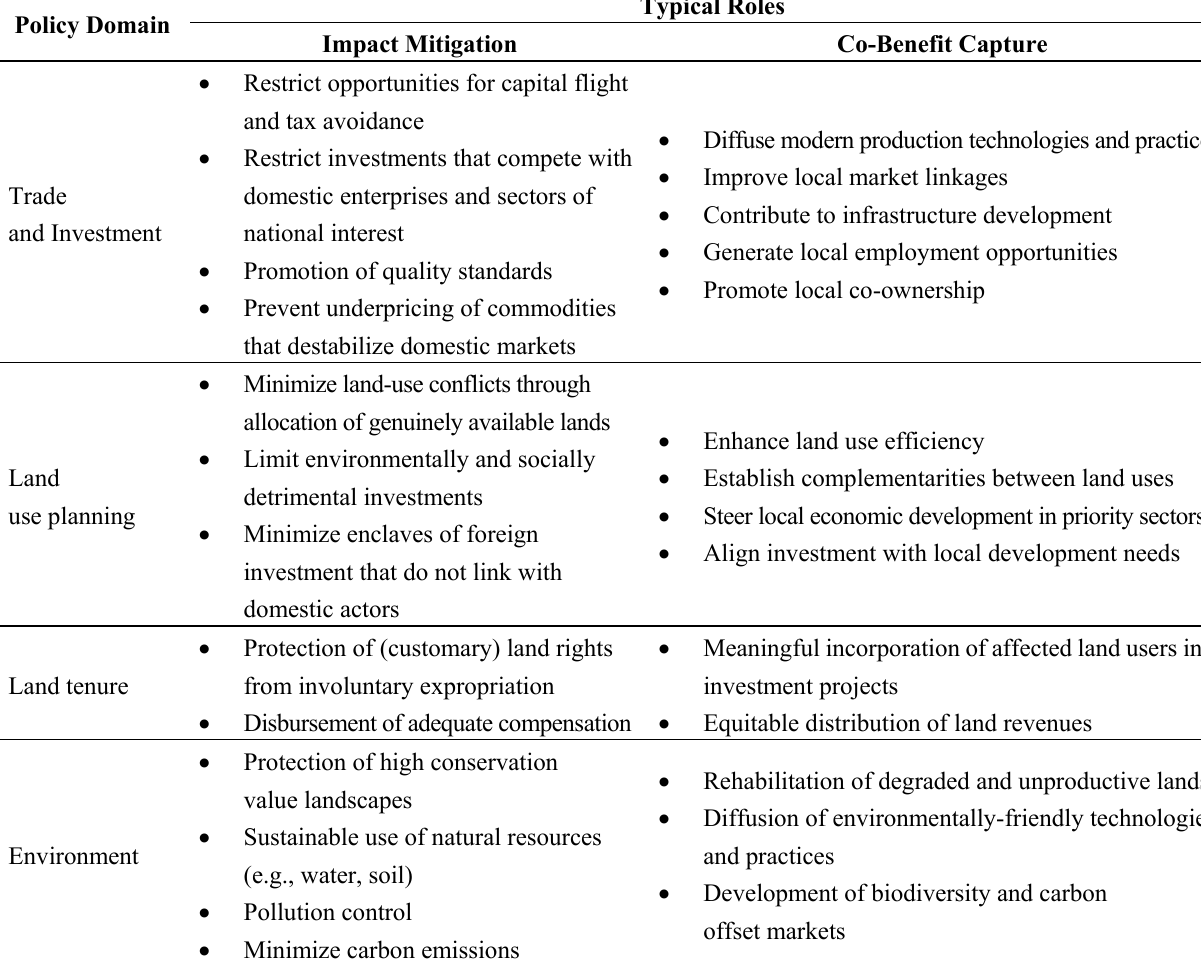
Table 1. Typical roles of key policy domains in relation to investment